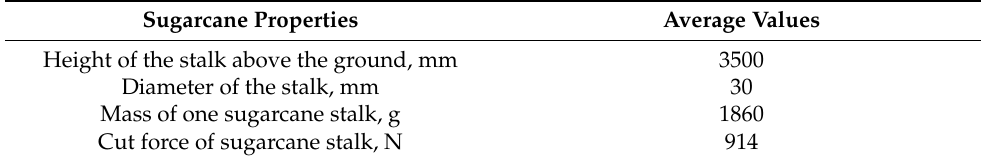
Table 1. Physical and mechanical properties of sugarcane (variety; C 9). Sugarcane Properties Height of the stalk above the ground, mm